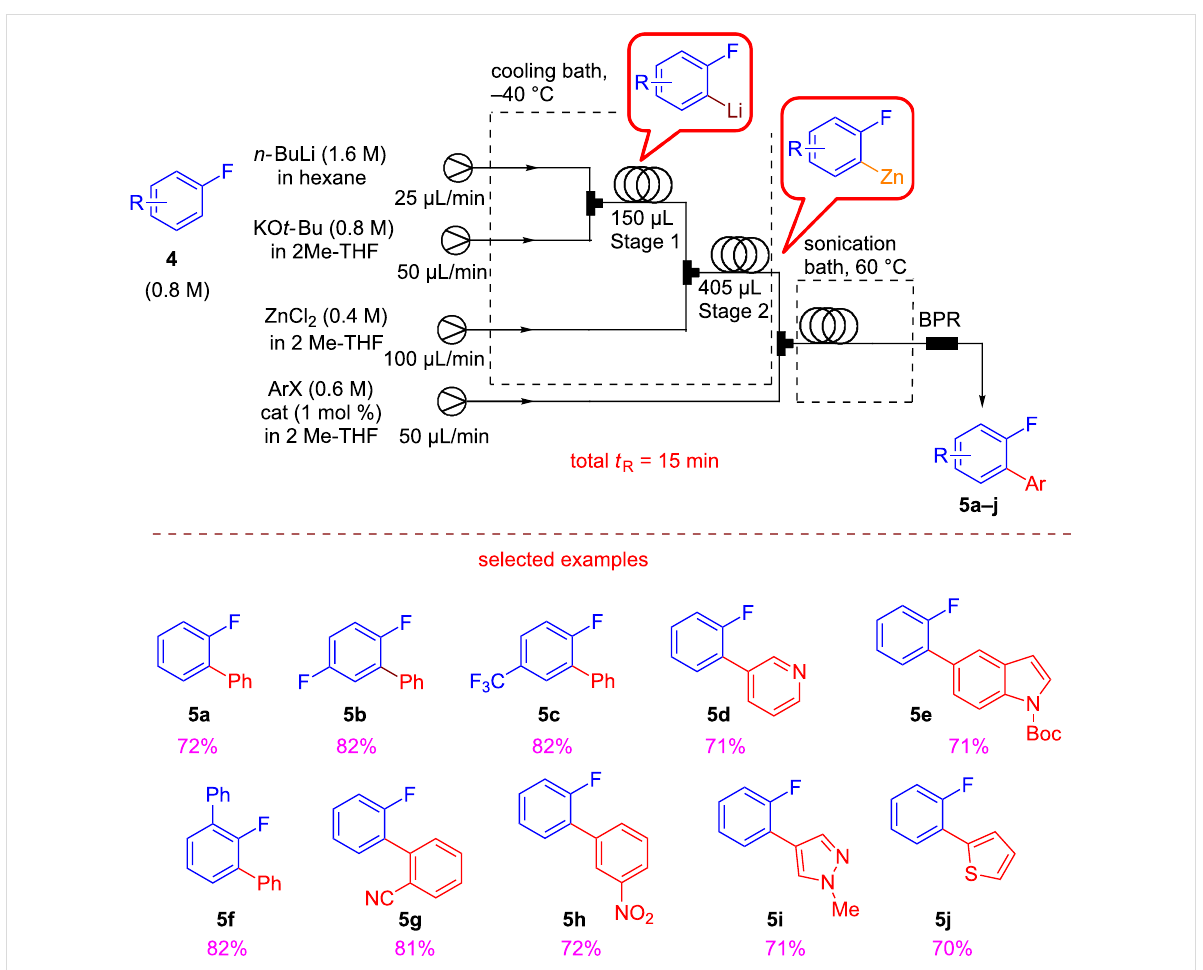
Scheme 9: Experimental setup for the flow synthesis of 2-fluorobi(hetero)aryls by directed lithiation, zincation, and Negishi cross-coupling. (Adapted with permission from [53], copyright 2016 Wiley-VCH Verlag GmbH & Co. KGaA,